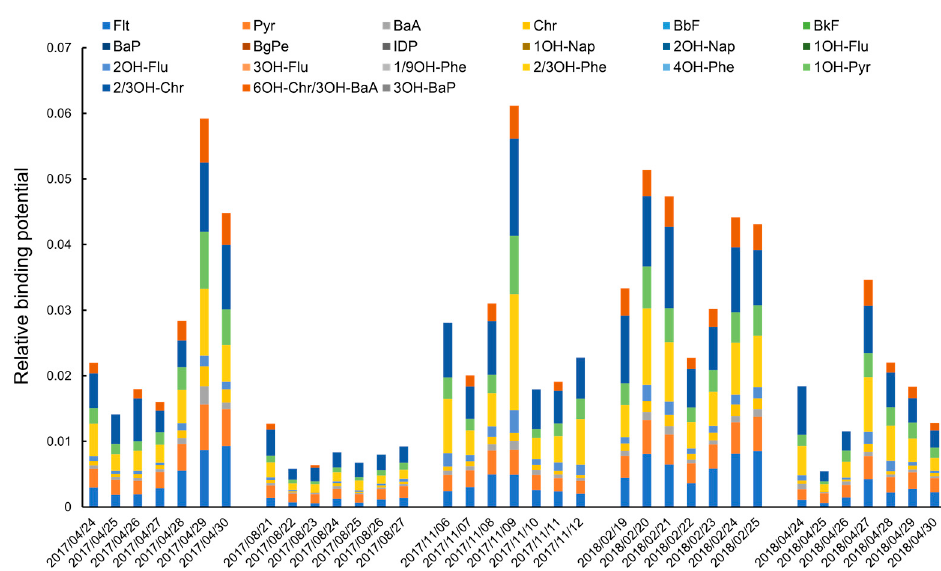
Figure 7. Daily relative binding potentials of atmospheric PAHs and OH-PAHs to the hER in April, August, and November 2017, and February and April 2018 in Kanazawa.